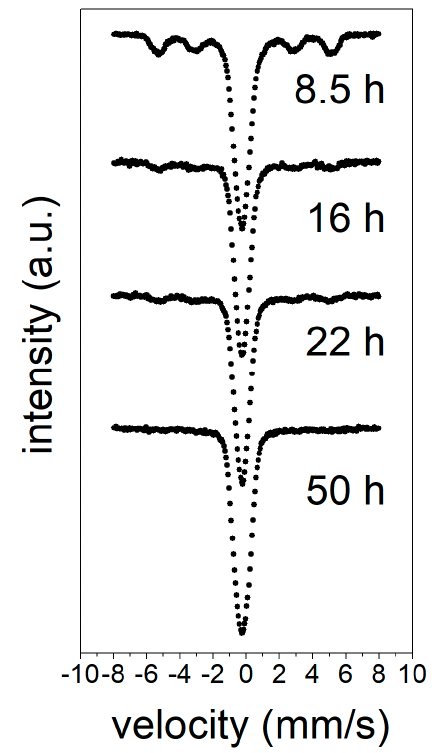
ff erent milling